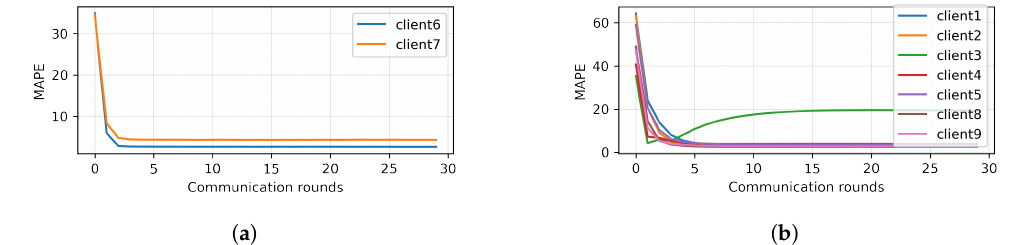
Figure 7. First round of clustering. ( a ) FL Result of Branch 2. ( b ) FL Result of Branch 1.